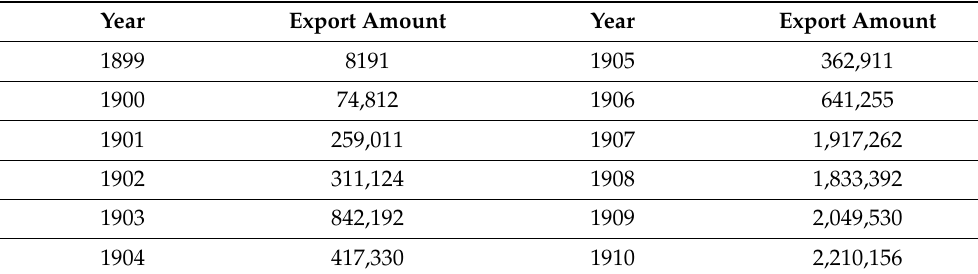
Table 1. Changes in exports after port opening [25].